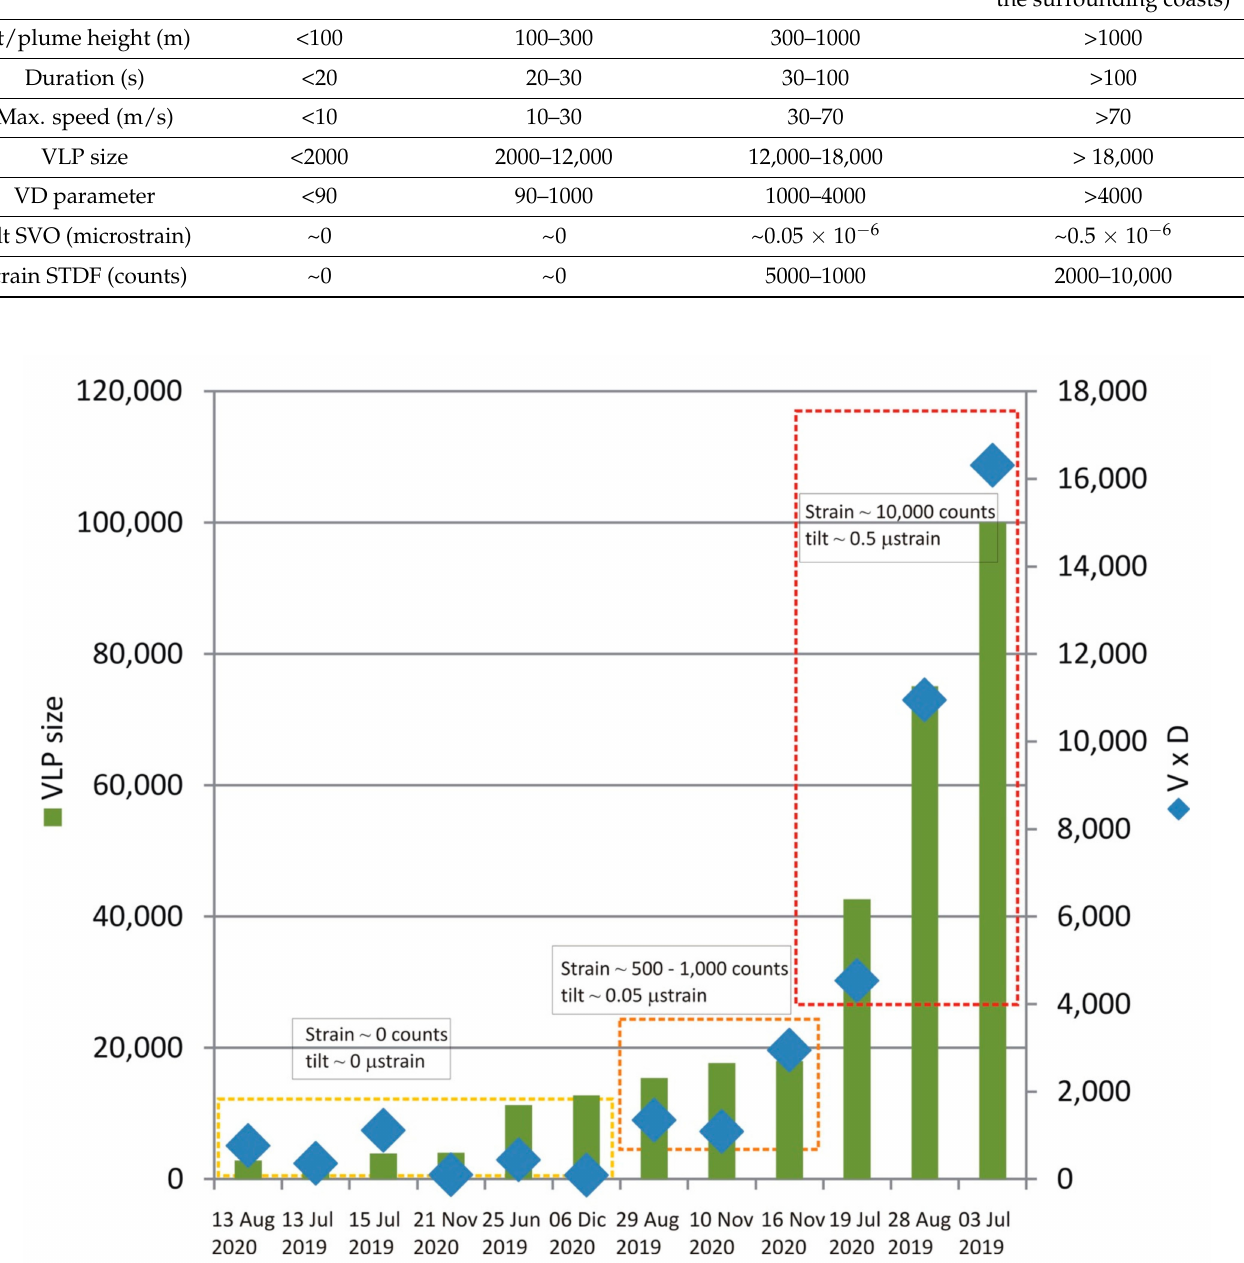
Figure 23. Summarizing diagram showing the classification proposed for the 12 explosive events considered in this paper on the basis of VLP size (left axis), and muzzle velocity by duration (right axis). See text for further